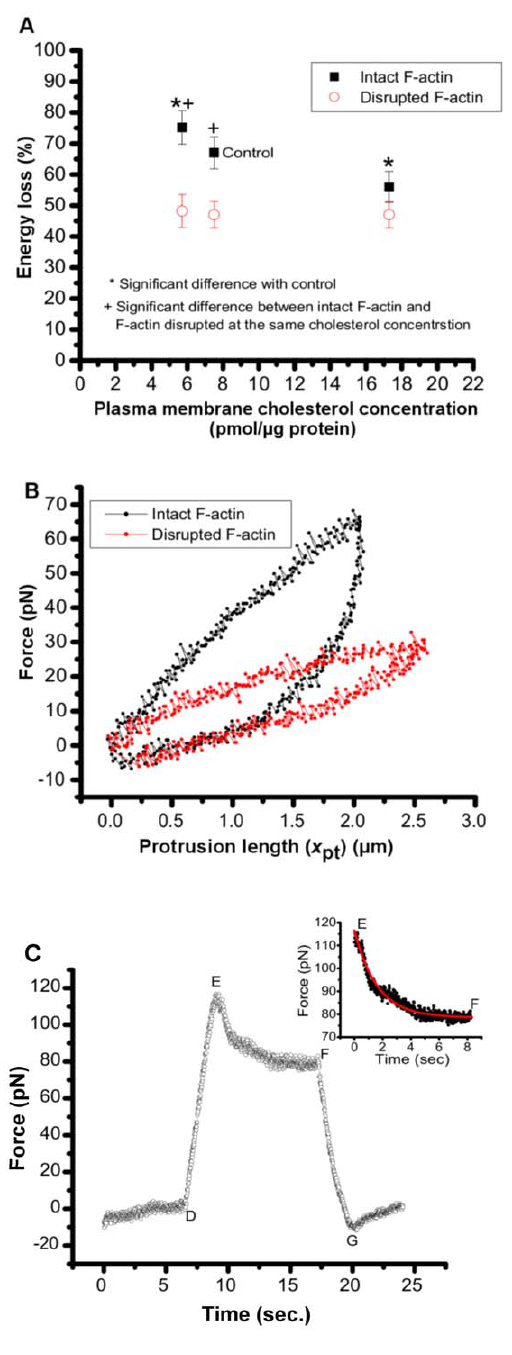
Figure 9. Energy loss associated with protrusion hysteresis. ( A ) Effect of membrane cholesterol content on the percent of energy loss associated with protrusion hysteresis for intact and disrupted F-actin cells. ( B ) Force-length plots indicating hysteresis in cells with intact and disrupted F-actin. lpar; C ) Protrusion force during protrusion elongation to 3 m m (time interval D–E) followed by force relaxation after the protrusion reaches 3 m m, and maintained at that length (time interval E–F). The intervalF–G displaysthe forceasthe protrusion is unloaded (pushed back). The inset shows the SLS-fit to the force relaxation during the time interval between the end of the pulling time and beginning of the pushing time (E–F). The general solution for the protrusion force relaxation under k 0 t ) , where x pt is the constant length is: f ( t ) ~ k 1 x pt z ( F 0 { k 1 x pt )exp( { g o constant length of the protrusion (3 m m), and F 0 is the force at